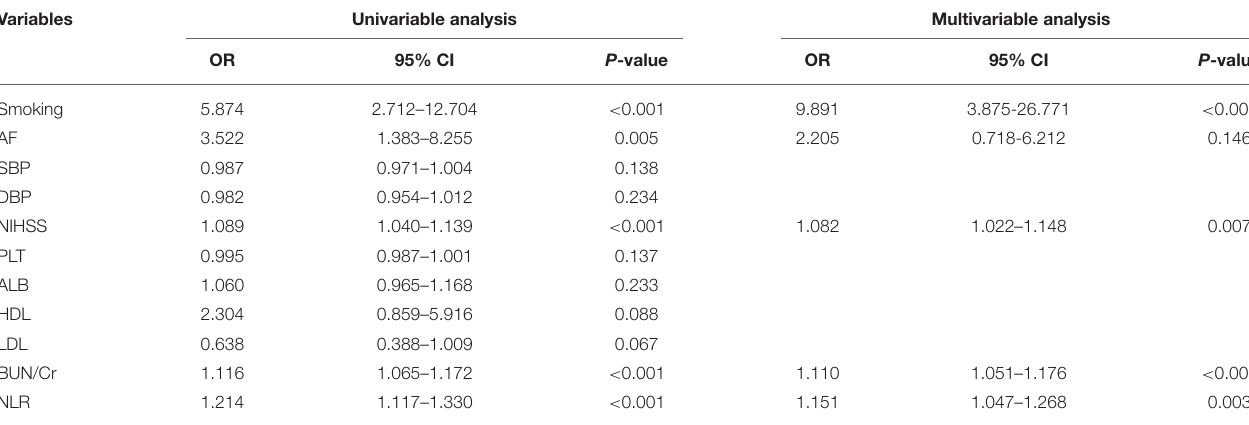
TABLE 3 | Univariable and multivariable analyses of intracranial hemorrhage in AIS patients with Intravenous thrombolysis in the training set. Variables Univariable analysis